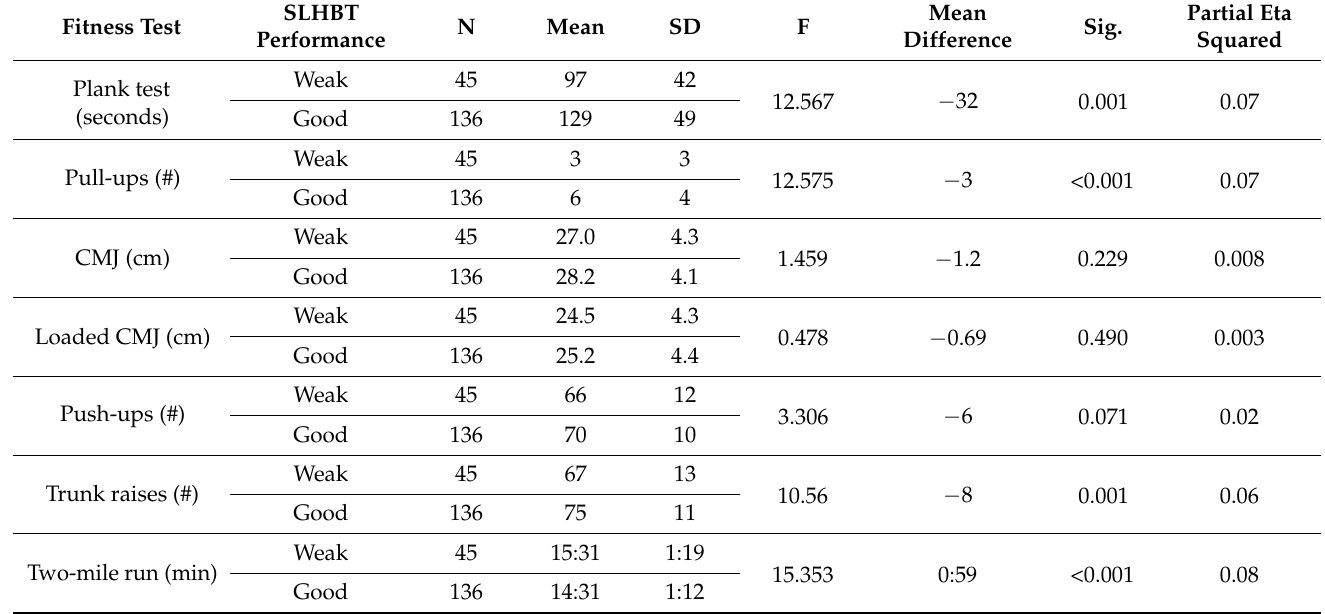
Table 2. Differences in the physical performance of soldiers with different hamstring